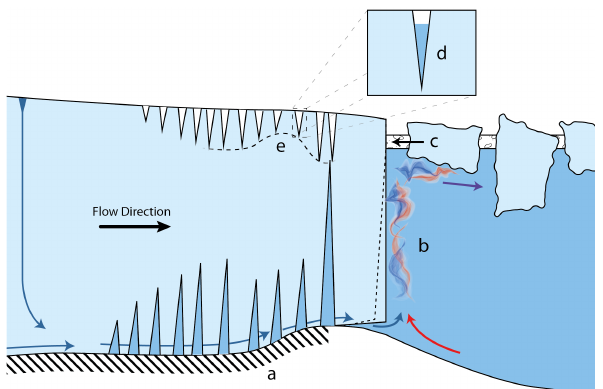
Figure 4. Schematic diagram showing proximal and distal processes affecting calving. a) Varying basal friction ( τ b ) affects the stress field in the glacier. b) Changing fjord water temperatures and subglacial water flux affect the rate of submarine melting of the calving face and floating tongue (when present). c) The seasonal formation of m´elange provides a buttressing force which suppresses surface crevasse depth and, thus, calving. d) Surface melt water in crevasses causes hydrofracturing, which acts to deepen surface crevasses. e) Glacier geometry exerts a strong influence on crevasse field depth: compressional forces on the stoss side of Store’s pinning point suppress the depth of crevasses, while rapid loss of basal traction in the lee side deepen them.